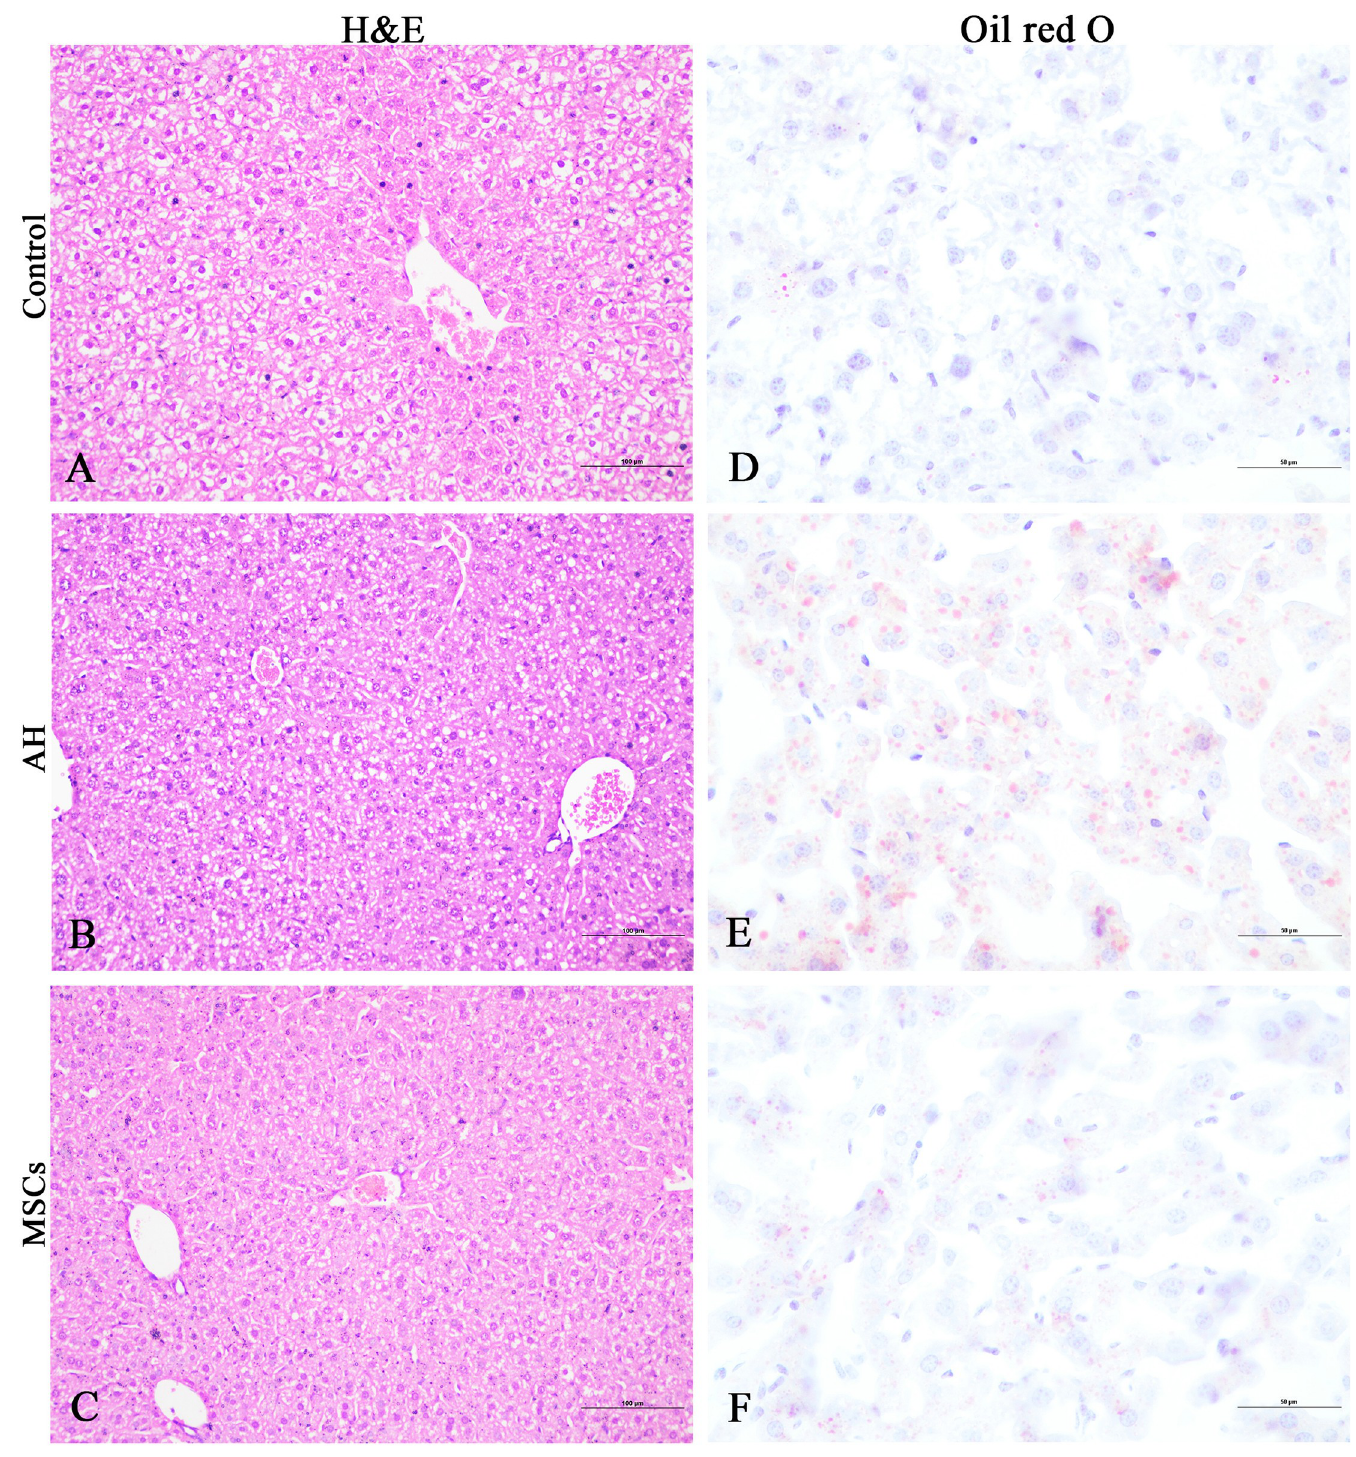
Fig 3. A-F MSCs reduced liver steatosis: hematoxylin & eosin staining for control (A), AH (B), MSCs (C) groups; oil red O staining for control (D), AH (E), MSCs (F) groups. Bars = 100 μ m (A-C) or 50 μ m (D-F). AH, alcoholic hepatitis; MSCs, mesenchymal stem cells.